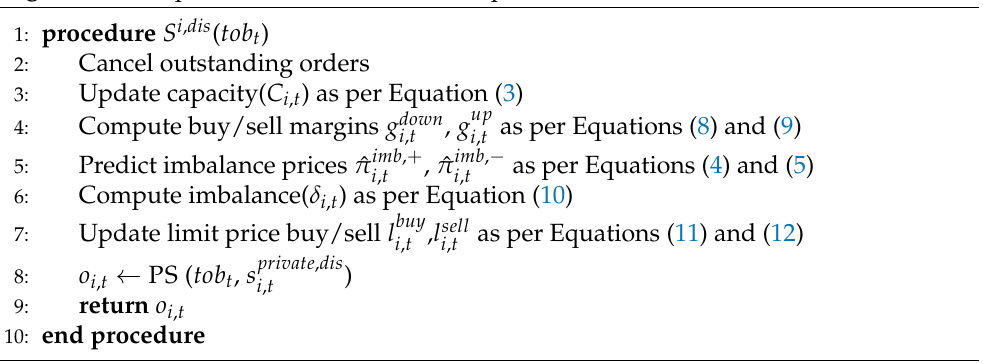
Algorithm 2 Steps to decide the orders to be